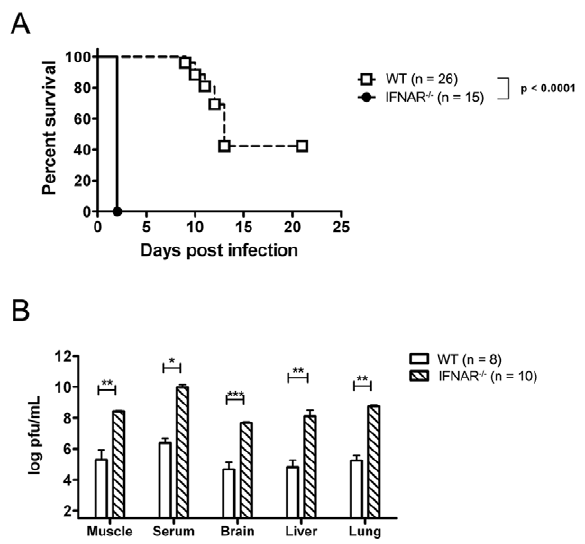
Figure 4. Endogenous Type I IFN is required for the control of neonatal CHIKV infection. WT and IFNAR 2 / 2 mice were infected at 9 days of age with 2 6 10 5 PFU CHIKV s.c. ( A ) Mice were monitored for lethality for 21 days with data displayed as Kaplan-Meier curves. ( B ) Tissue and sera were collected on day 1 post-infection and viral titers were determined using a standard plaque assay. Mann-Whitney statistical comparison of WT and IFNAR 2 / 2 viral titers are shown where * indicates p , 0.05, ** p , 0.005 and *** p , 0.0005, and vertical bars represent standard error of the mean.